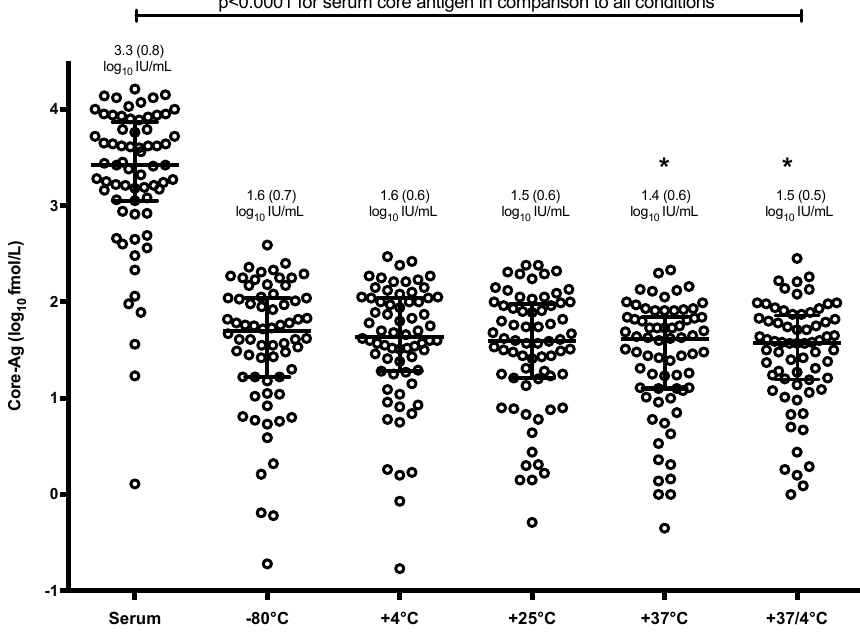
Figure 1. Distribution of core-Ag concentration by dried blood spots (DBS) storage condition as compared to serum . Bars represent mean and standard deviation. Environmental conditions with an astrix (*) have a mean statistically significant difference from -80 ° C ( p < 0.05).